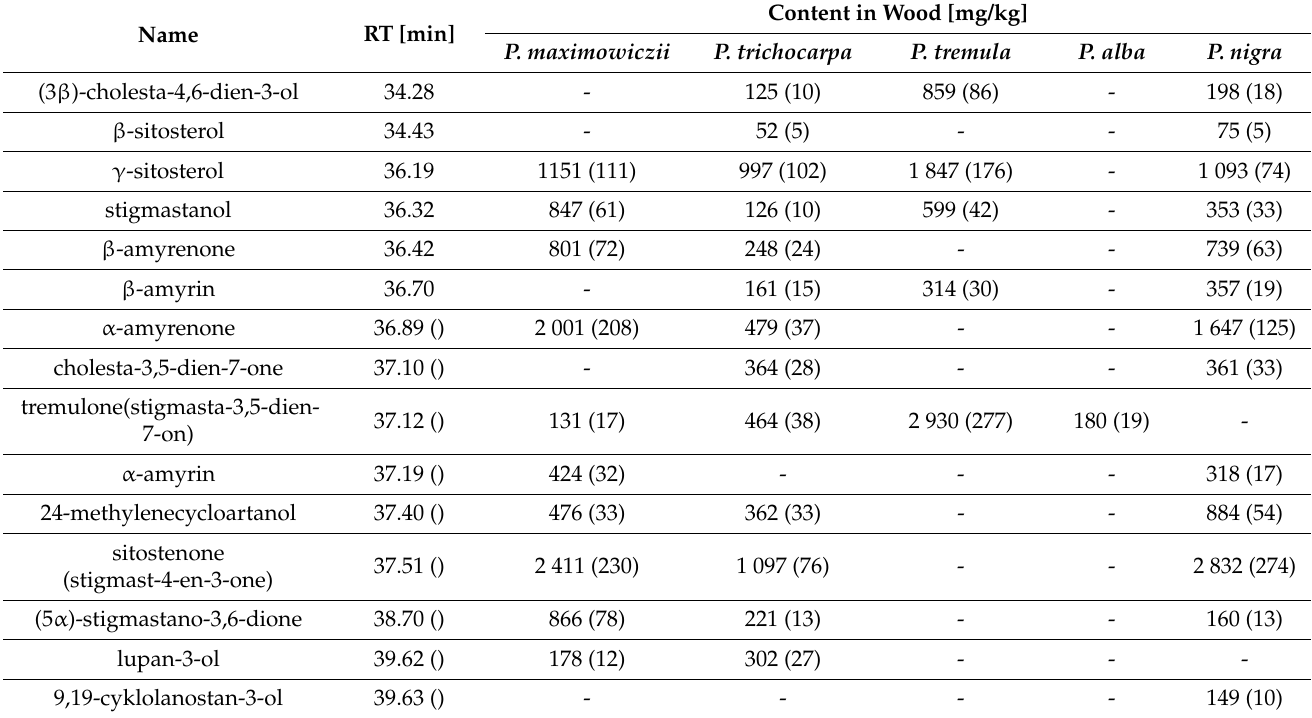
Table 5. Sterols and terpenoids identified in wood extracts from tested poplar